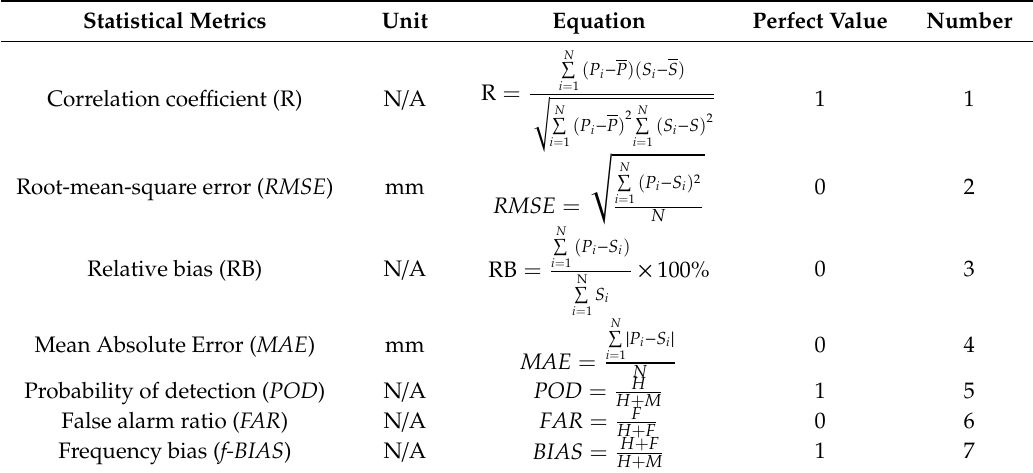
Table 1. List of the statistical metrics employed to quantify the performance of the satellite-based precipitation products (SPPs) [28,36,37].